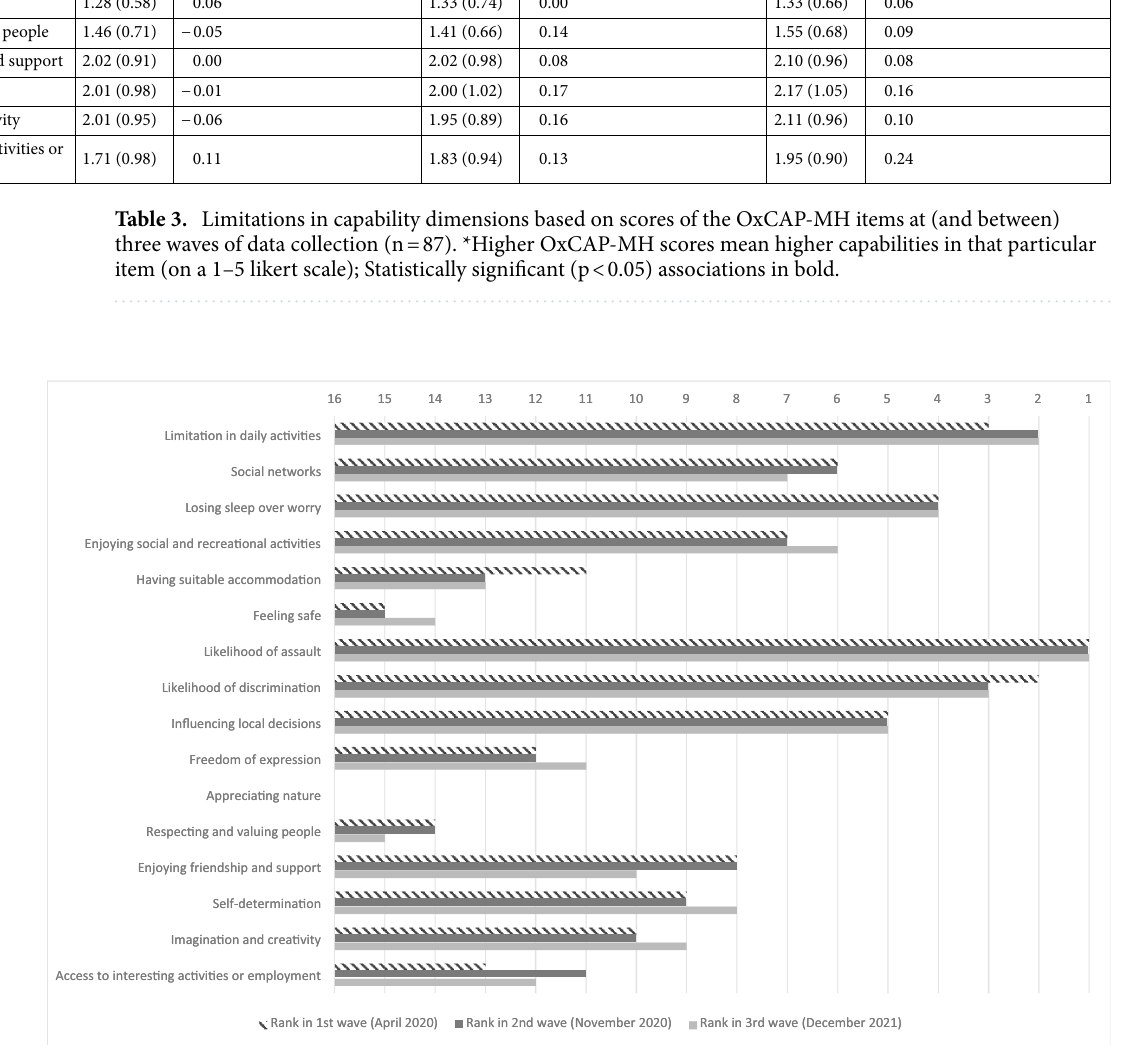
Figure 2. Ranking of OxCAP-MH items at each wave of data collection. OxCAP-MH—Oxford CAPabilities questionnaire-Mental Health; longer bars mean higher capabilities and less